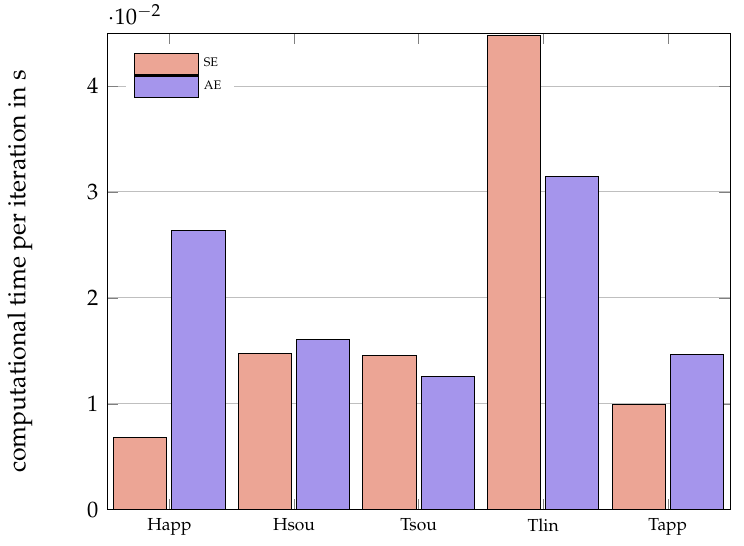
Figure 8. Mean values of time per iteration for each solver